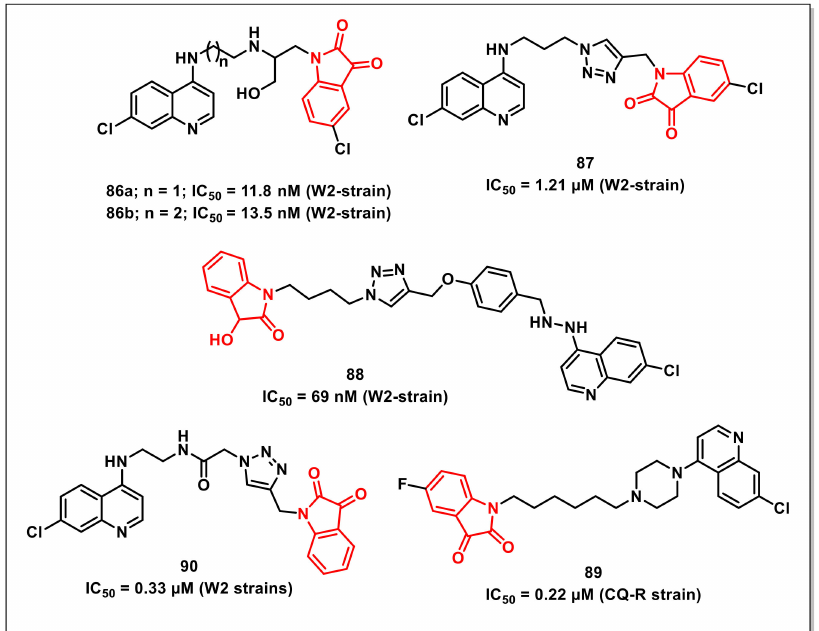
Figure 14. Isatin-7-chloroquinoline hybrids as